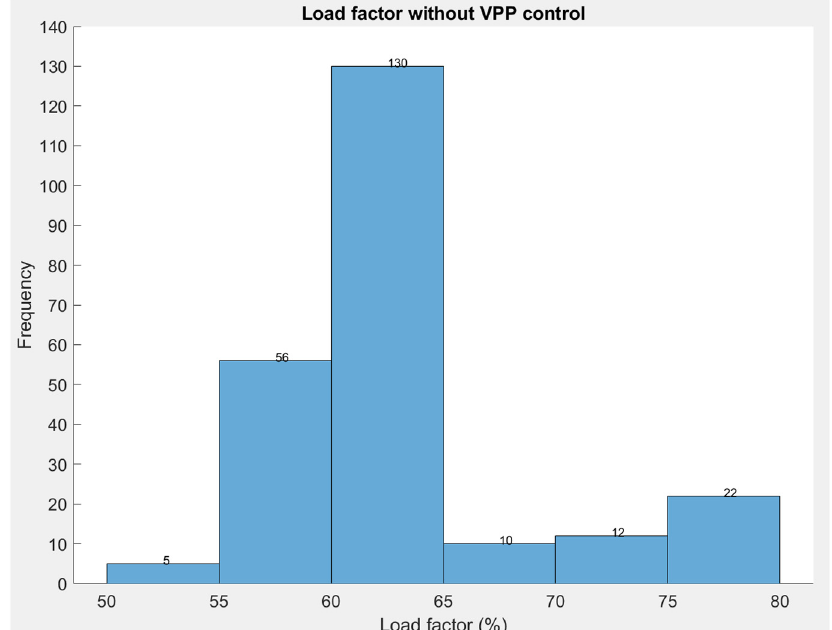
Figure 11. Histogram of SA1s’ original load factors without VPP control.